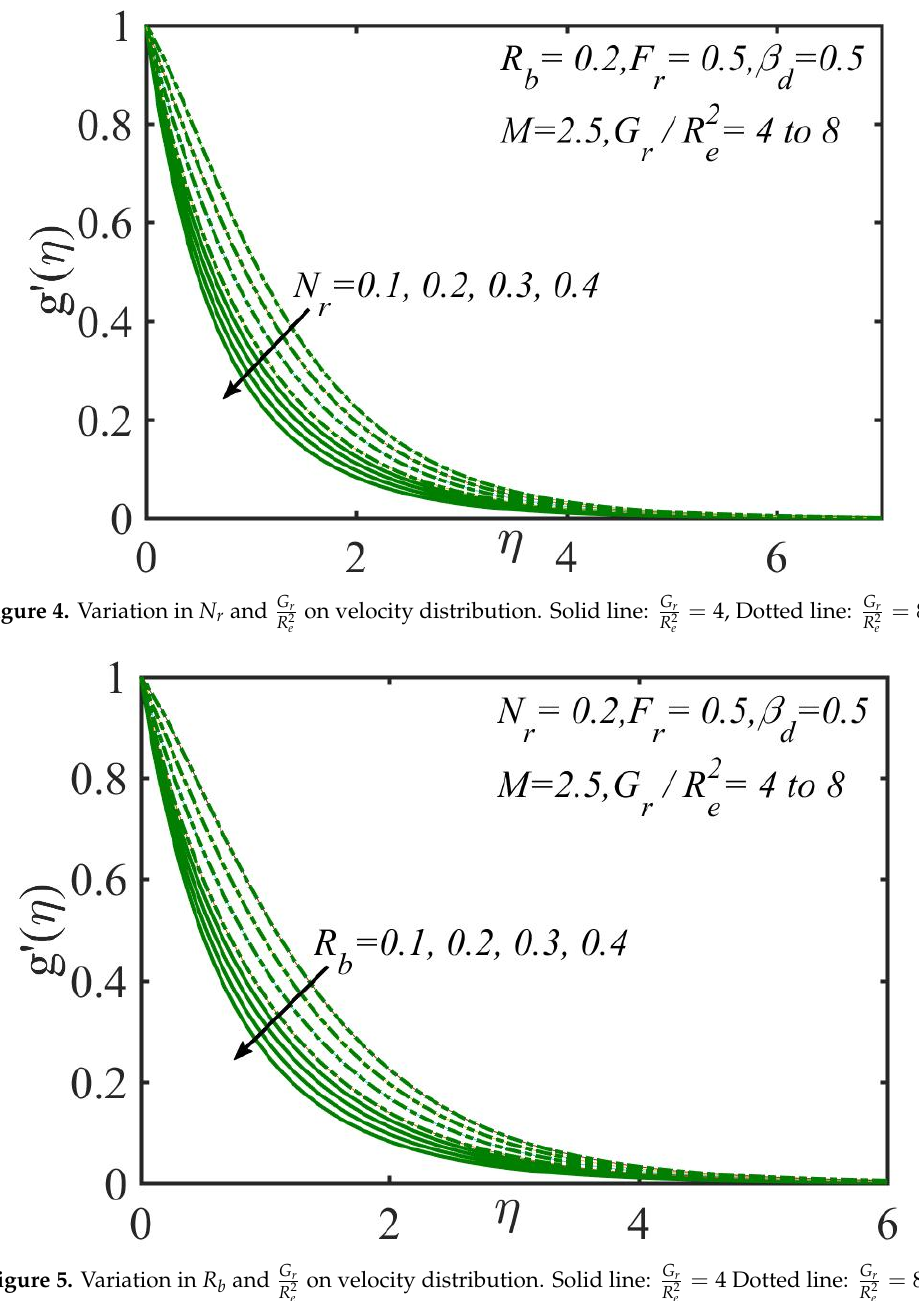
Figure 5. Variation in (cid:1844) (cid:3029) and (cid:3008) (cid:3293)